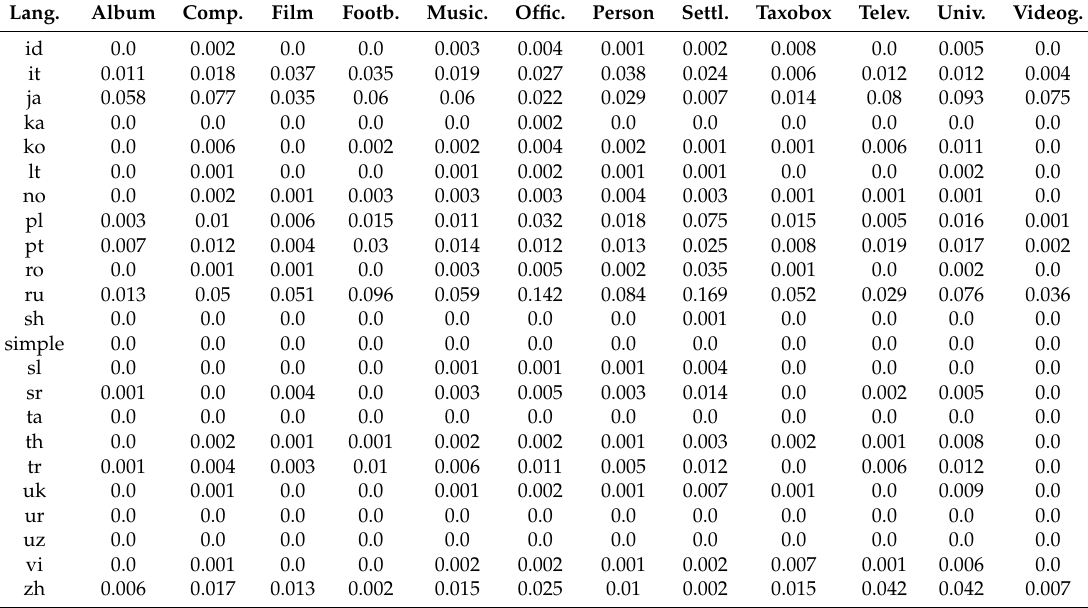
Lang. Album Comp. Film Footb. Music. Offic. Person Settl. Taxobox Telev. Univ. Videog.